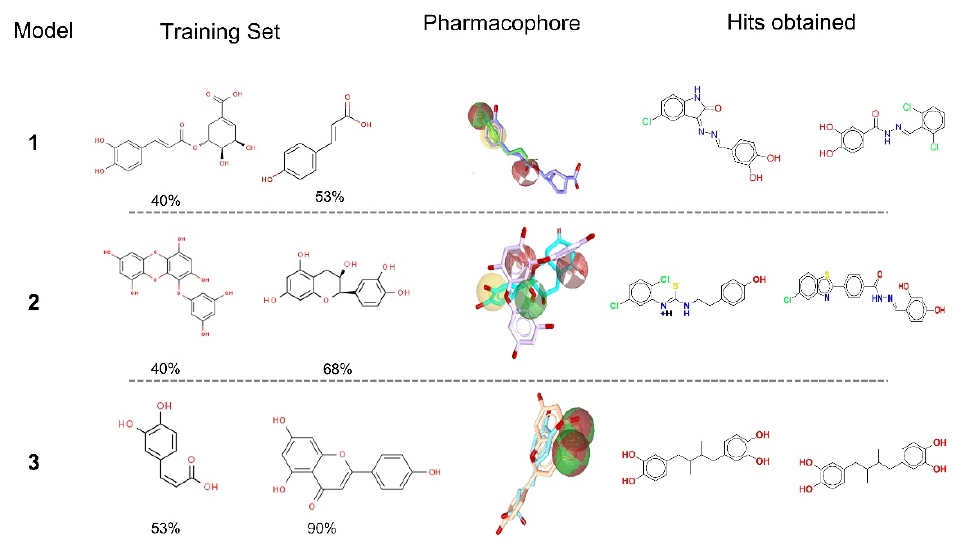
Figure 2. Chemical structures of the training set employed for pharmacophore modelling, and the top-ranked hits from each model.